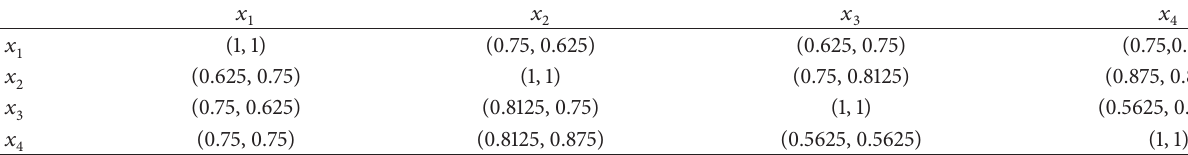
Table 6: Consensus levels of preference values provided by 𝑒 3 .